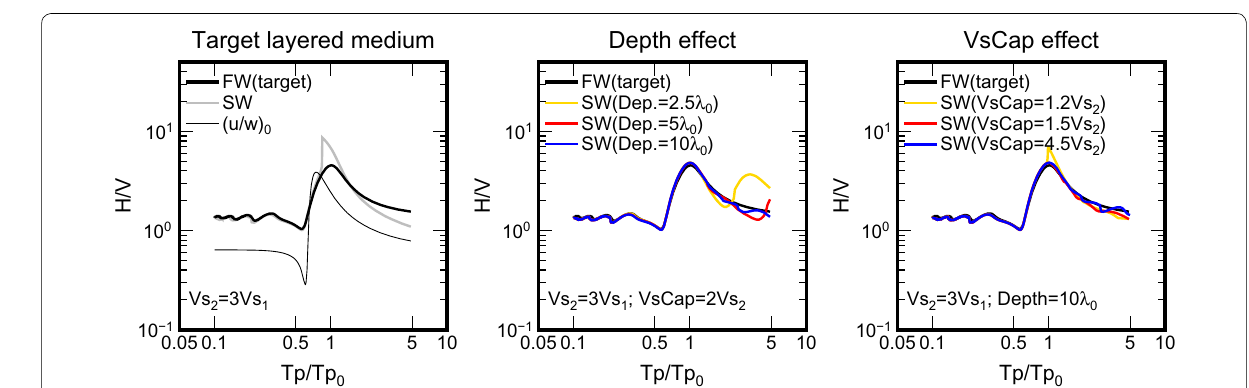
Fig. 1 Comparison between FW H / V , SW H / V , ellipticity of fundamental mode of Rayleigh waves of target two‑layered medium, and SW H / V of cap‑layered media. Left: ellipticity of fundamental mode of Rayleigh waves (thin black), FW (thick black) and SW (gray) H / V s of target two‑layered medium of which the S‑wave velocity in the second layer ( V s2 ) is three times as large as that in the first layer ( V s1 ). Middle: FW H / V of target two‑ layered medium and SW H / V s of three cap‑layered media of which the depths of upper interface of cap layer are 2.5 times (gold), 5.0 times (red), and 10 times (blue) the wavelength ( λ 0 , corresponding to fundamental mode of target two‑layered medium), and the S‑wave velocities of cap layer ( V sCap ) 2 V s2 . Right: SW H / V s of three cap‑layered media of which V sCap = of upper interface of cap layer are 10